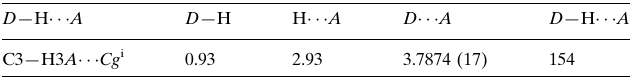
Hydrogen-bond geometry (A˚ , (cid:1) ). Cg is the centroid of the phenyl